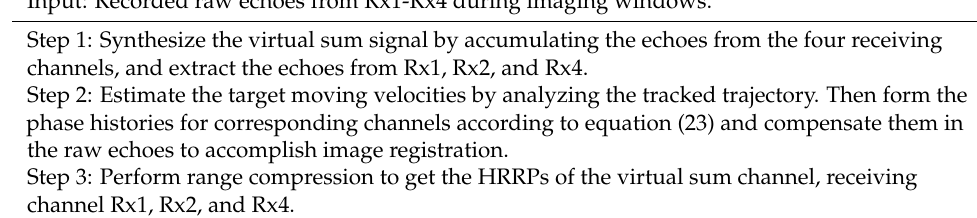
Table 2. Practical procedures of the InISAR imaging.